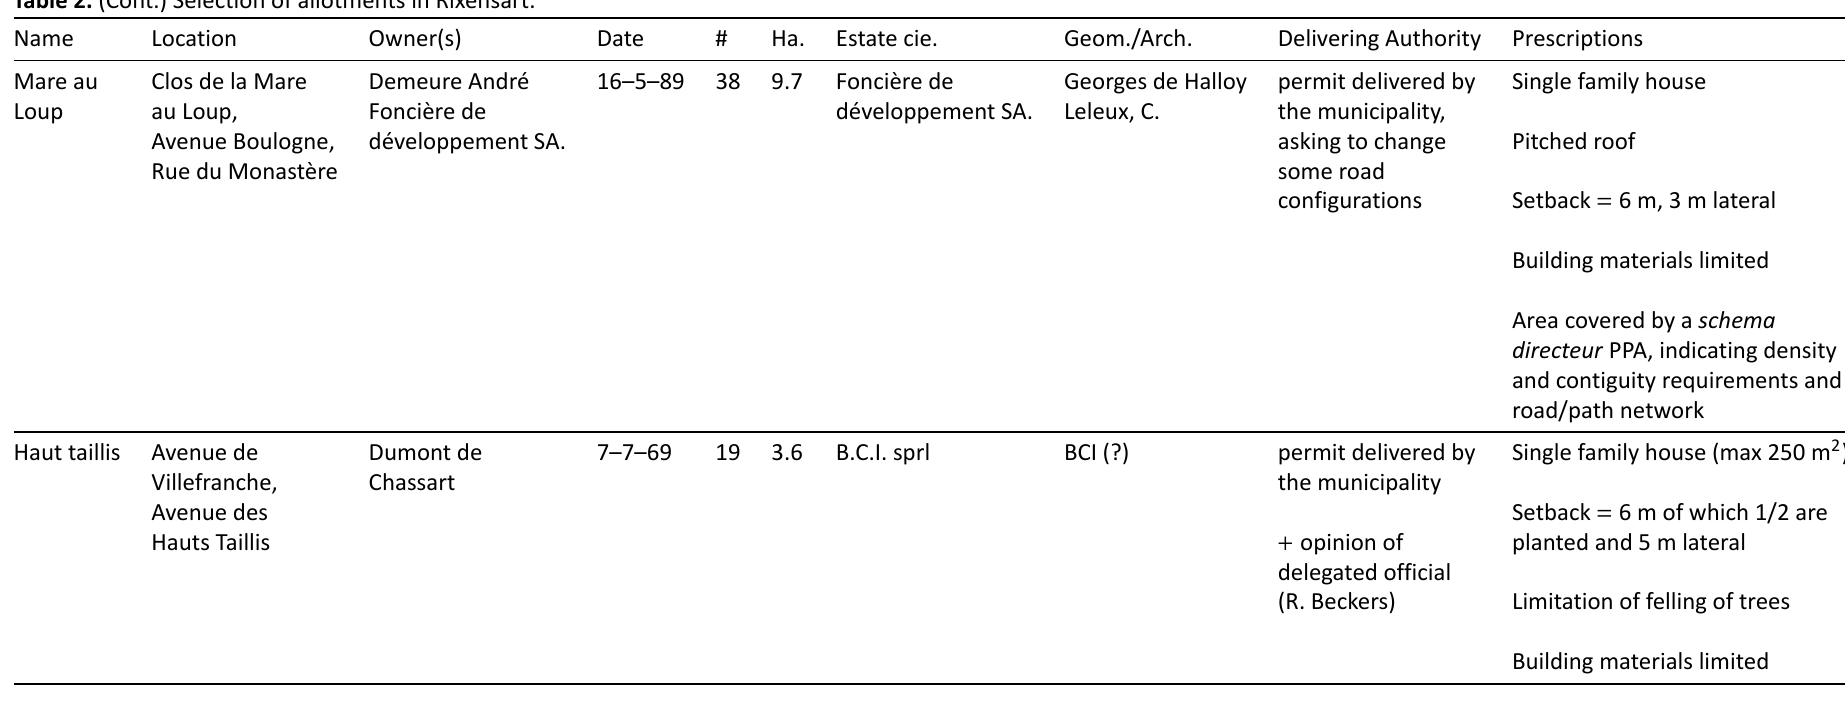
Table 2. (Cont.) Selection of allotments in